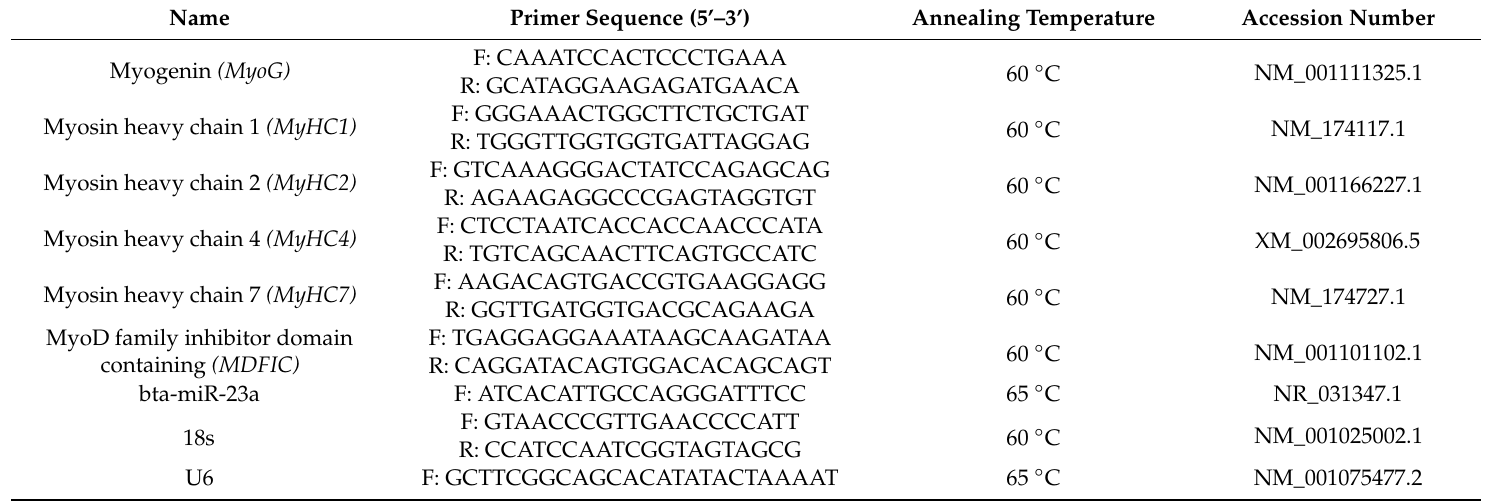
Table 1. Sequences designed for real-time